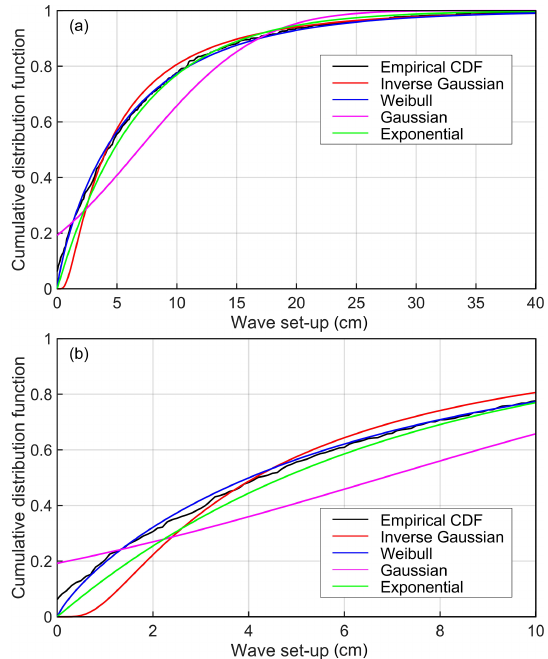
Figure 12. (a) Match of the cumulative distribution function of the empirical distribution of occurrence for different set-up heights for the data presented in Fig. 8 with inverse Gaussian, Weibull, Gaus- sian, and exponential distributions. (b) The same match for set-up heights ≤